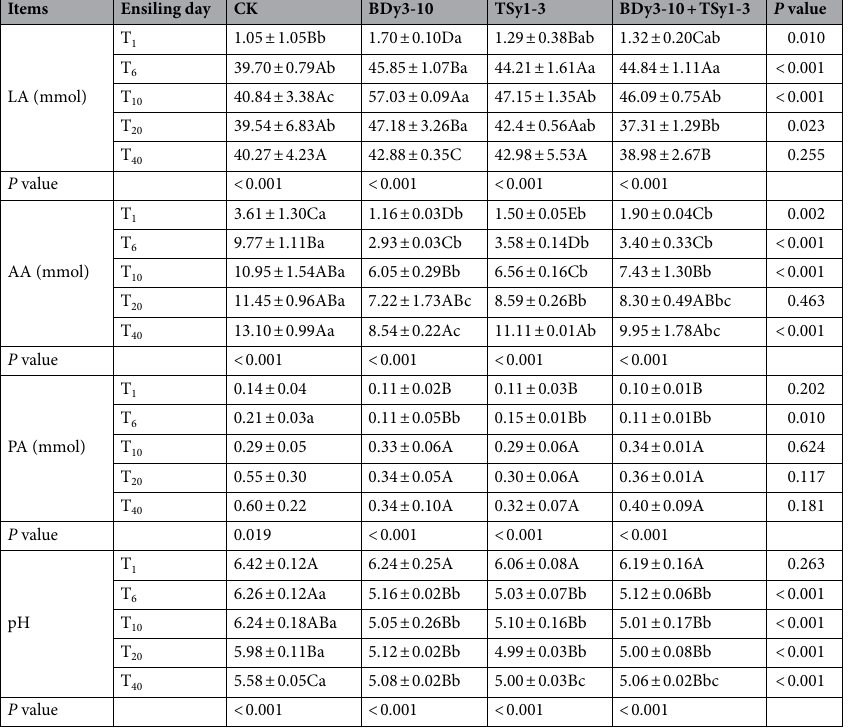
Table 7. Contents of LA, AA, PA and pH dynamic changes during ensiling. a– c Means having different letter superscripts within column are significantly different ( P < 0.05). A–E Means having different letter superscripts within row are significantly different ( P < 0.05). LA lactic acid, AA acetic acid, PA propionic